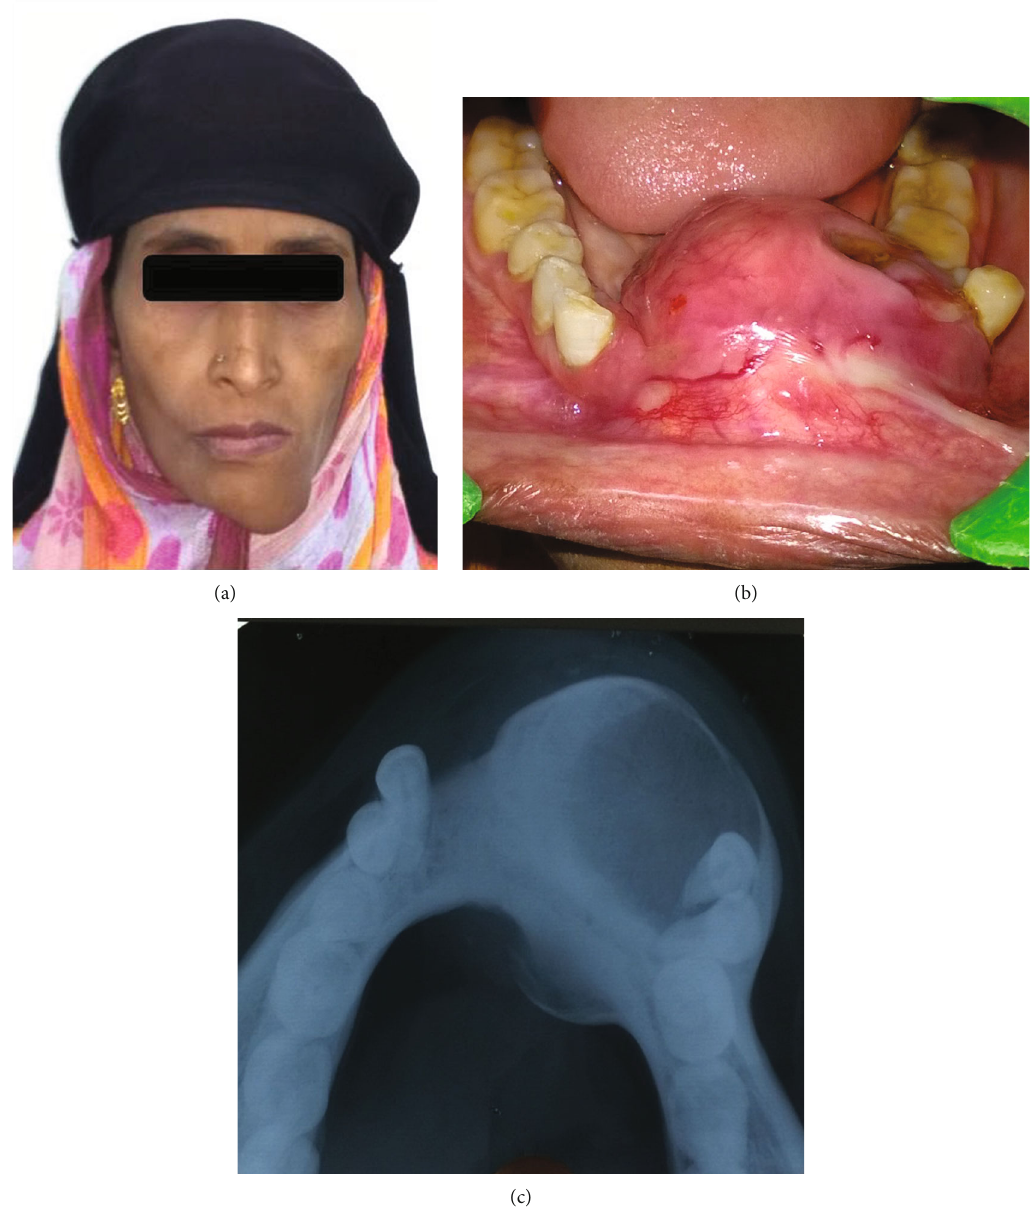
Figure 1: (a) Extraoral swelling; (b) intraoral ulcerated mass with obliteration of labial vestibule; (c) radiographic presentation showing the expansion of cortical